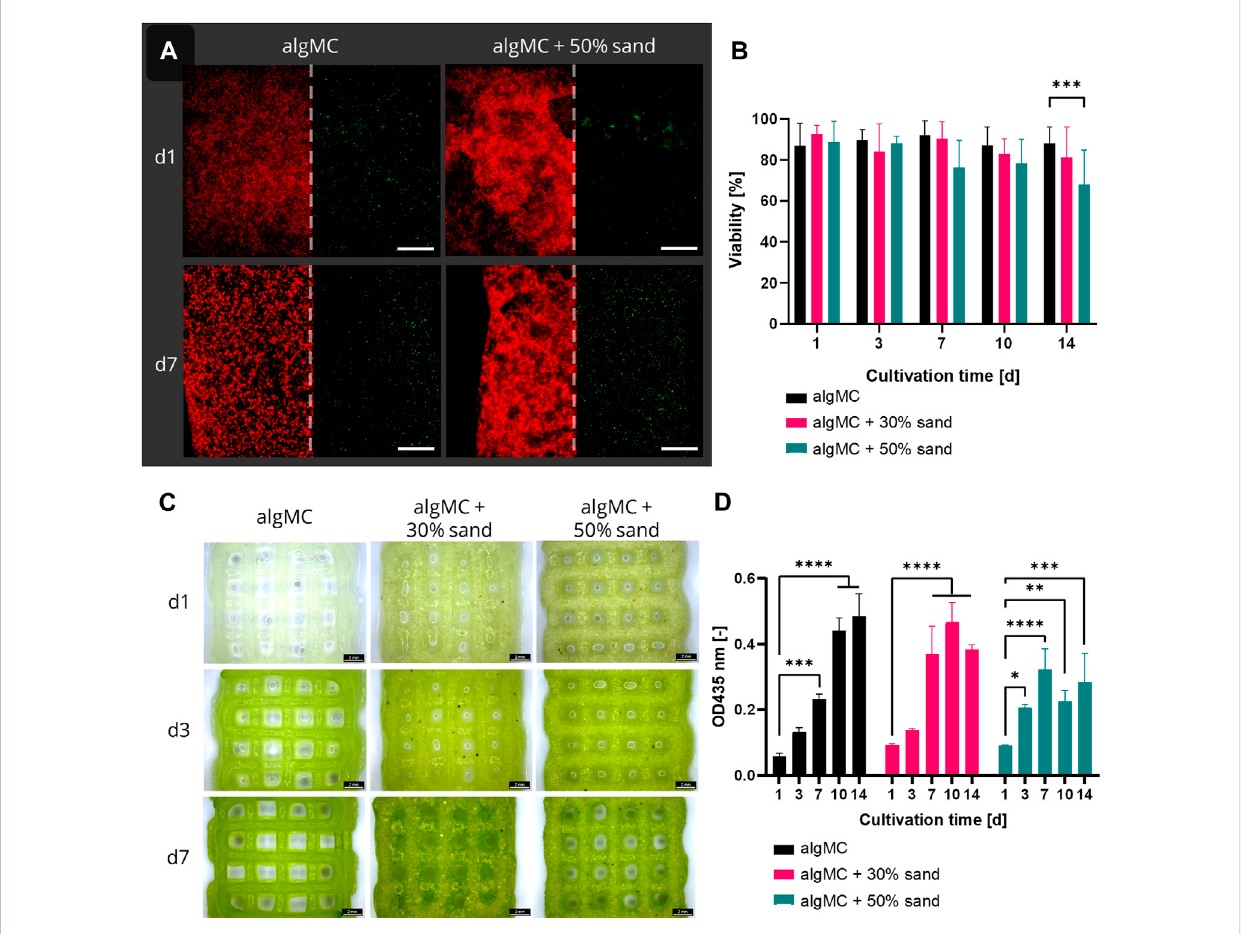
FIGURE 4 (A) Fluorescence microscope images of immobilized PCC 7002 in the algMC bioink with and without the addition of 50 wt% sand. Living cells show red auto fl uorescence (left), dead cells appear green (right). Scale bars = 200 µm. (B) Viability of PCC 7002 in the algMC bioink without, with 30 wt% and 50 wt% of sand, respectively, over a cultivation period of 14 days (data shows mean ± SD, n ≥ 5 of two individual experiments, *** p < 0.001). (C) Stereomicroscopic images of algMC scaffolds without with 30, and with 50 wt% sand after 1, 3, and 7 days of cultivation. Scale bar = 2 mm. (D) Measurement of the optical density (OD) at 435 nm (chlorophyll content) over a cultivation period of 14 days (data shows mean ± SD, n = 3, * p < 0.05, ** p < 0.01, *** p < 0.001, **** p <